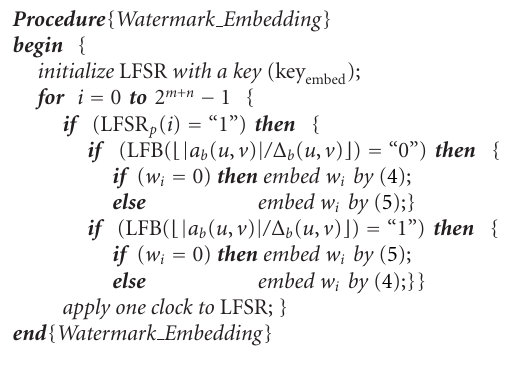
Algorithm 2: Watermark embedding procedure.